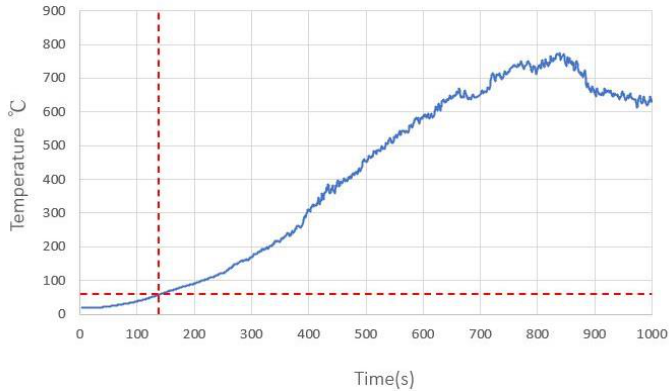
Figure 1. Curve of average temperature data on the third floor.